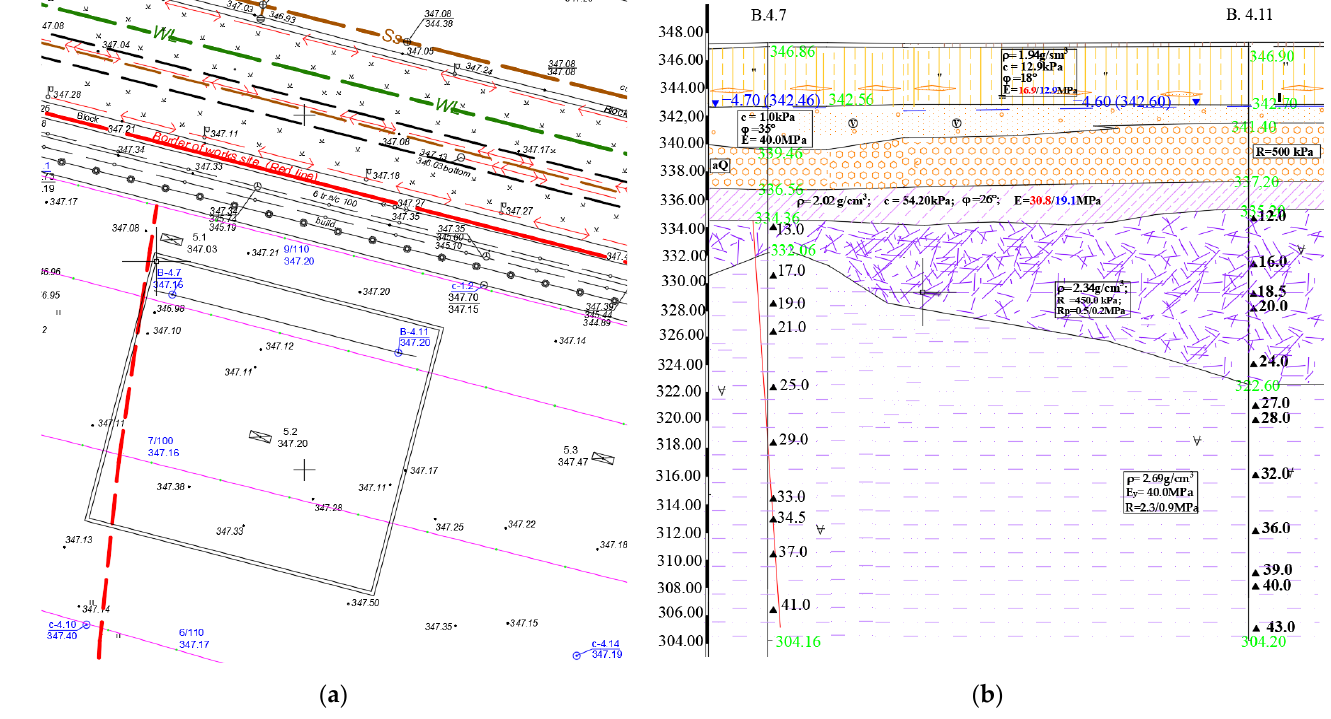
Figure 4. Construction site: ( a ) survey plan; ( b ) engineering-geological profile. Block R is the tallest building in the complex and is a 75-storey residential building with a 4-storey underground parking at the base. The foundation structure of the building consists of a pile raft, including Auger Cast Piles of 1125 m and boring piles with a diameter of 1.2 to 1.5 m. The length of the piles varies depending on the height of blocks, from 13 to 25 m, of high-strength concrete with an exposure durability of 40 MPa. The raft is built form the C28/35 concrete. The maximum design excavation level for the construction of a raft for block R was − 19.30 m. The basement floors consist of 4 levels from B1 to B4. On the B1 level there is an analyzer of the monitoring system for temperature and strain data collected via a distributed fiber optic strain sensing system (DFOSS) on the B4 level (Figure 5). The direction of data reading is shown by arrows. The applied DFOSS system transmits the signal via a grid of fiber optic cable to the B4 raft linked to an analyzer located in a temperature- and humidity-controlled room at the B1 level. The transmission process is based on the backscattering of light, which is transmitted through an optical fiber almost without loss. The basis of backscattered light is produced by Brillouin scattering [15]. The frequency of Brillouin backscattering of light at any point along the length of the fiber depends on the strain and temperature at that point. Thus, given that the optical fiber transmits light pulses in full, by analyzing the frequency of backscattered light, it is possible to accurately determine the effects of temperature and deformation anywhere along the fiber. Brillouin frequency shift v B is proportional to the local velocity of the acoustic waves.